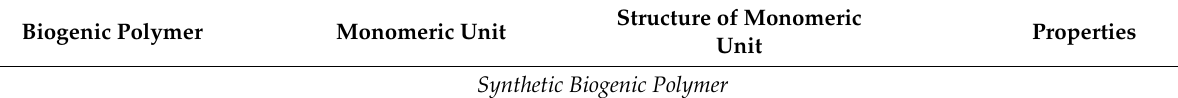
Table 2. Properties of synthetically-derived biogenic polymers used in food